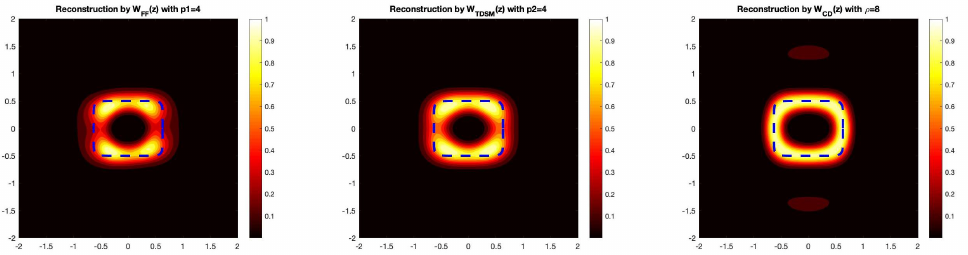
Figure 5. The reconstruction of the rounded square by the three direct sampling imaging